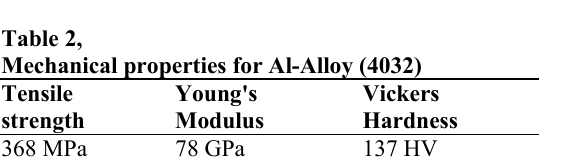
Mechanical properties for Al-Alloy (4032) Tensile strength